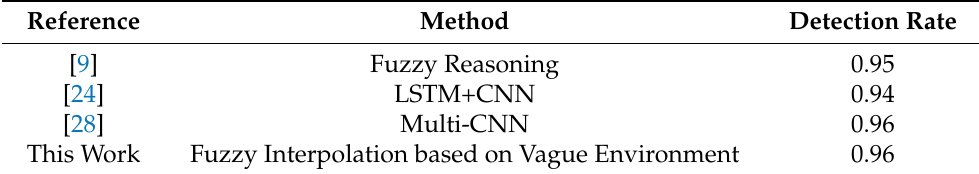
Table 3. Comparison of the Suggested Method with Other